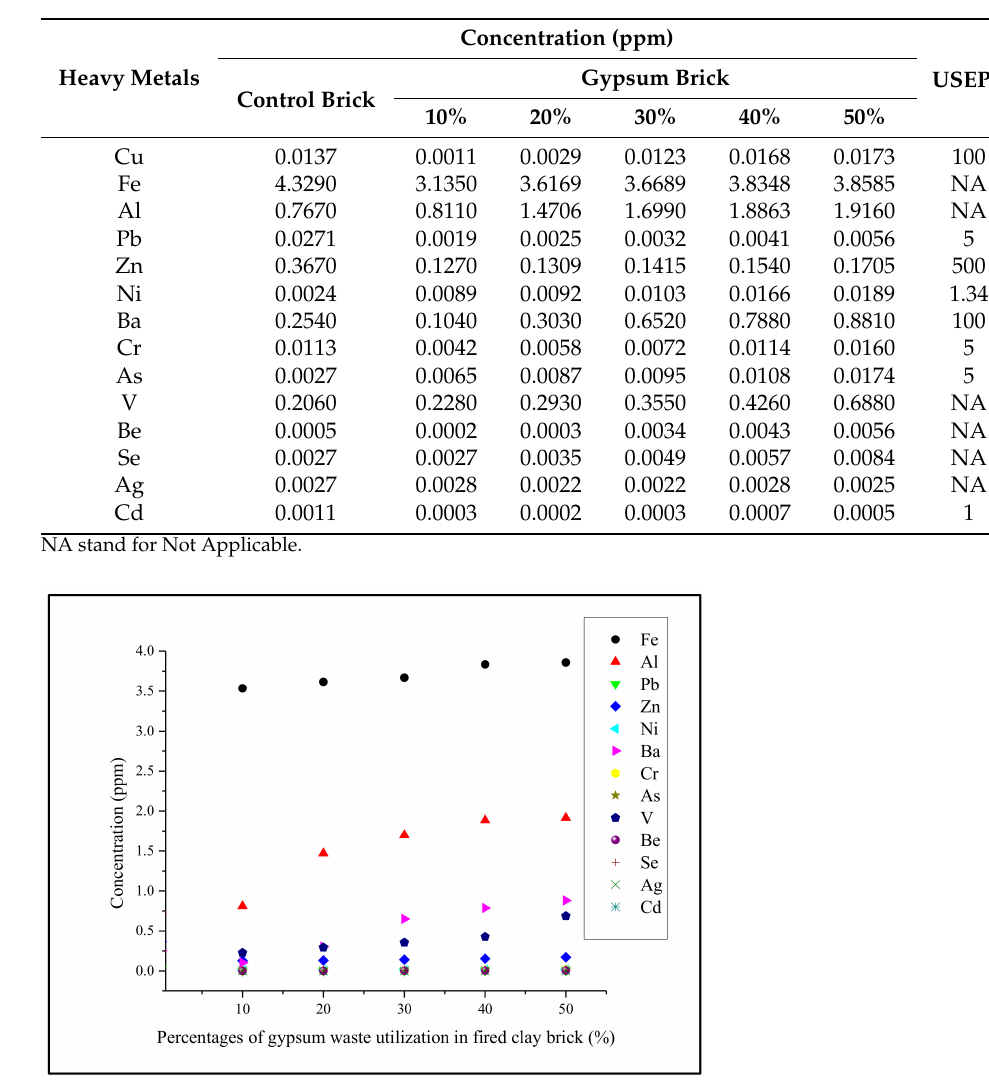
Figure 6. Effect of gypsum waste utilization on the leachate concentration of heavy metals in fired clay